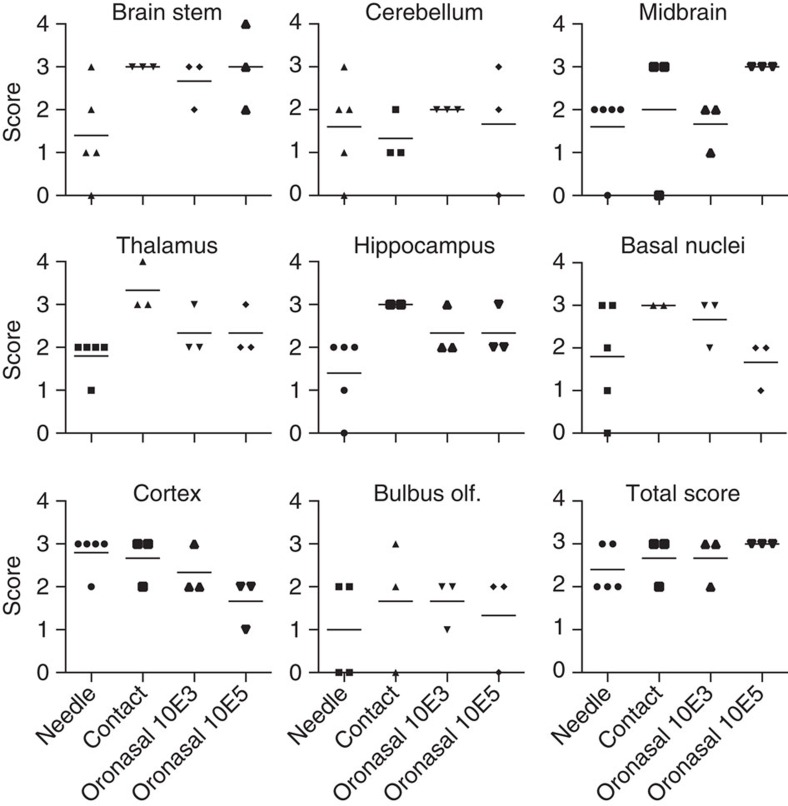
CNS lesions in pigs are not dependent on the route of infection.Lesions in the central nervous system were semiquantitatively scored from 0 to 4 (0: no lesions; 1: minimal lesions; 2: mild lesions; 3: moderate lesions; 4: severe lesions) as described in the Methods section. The needle-infected group (needle) was analysed 6 and 10 days after the onset of viraemia (taken as a measure due to the unknown infection time and different incubation periods of the other groups). Tissue from pigs infected by contact (contact) was 4, 6 and 7 days after the onset of viraemia. Tissue from oronasally infected animals was 7, 8 and 9 days after the onset of viraemia. CNS tissue from the animals infected with 103 TCID50 (oronasal 10E3) and 105 TCID50 (oronasal 10E5) is shown. olf., olfactory.